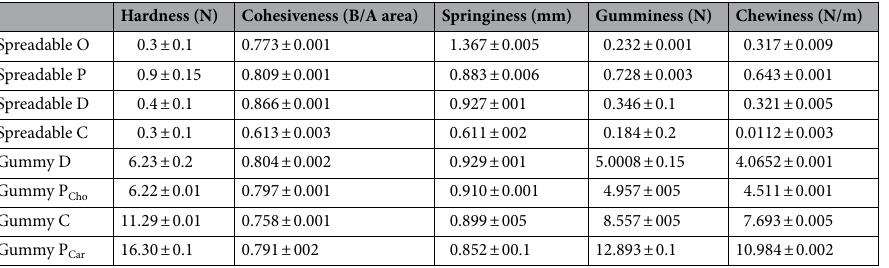
Table 3. Texture profile analysis of functional spreadable oleogel and healthy nutritional gummy